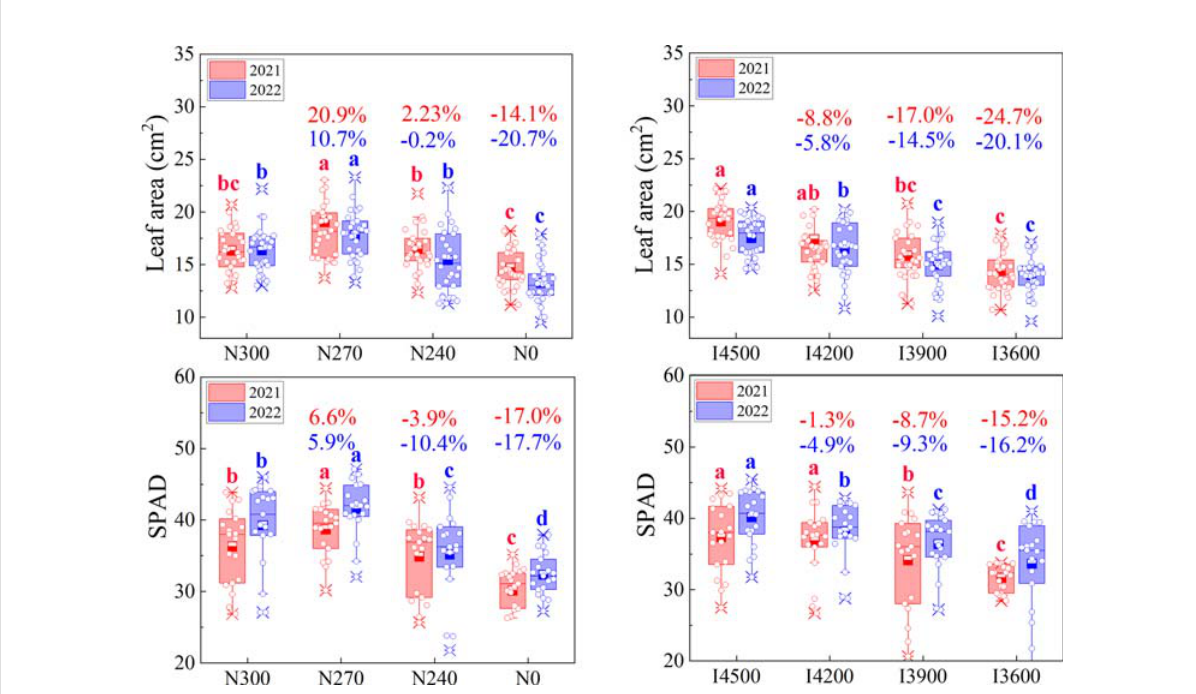
FIGURE 7 Effects of irrigation and nitrogen levels on fl ag leaf area and SPAD at anthesis stage. I4500, I4200, I3900, and I3600 indicate 4500, 4200, 3900, and 3600 m 3 ha − 1 irrigation levels, respectively. N300, N270, N240, and N0 indicate 300, 270, 240, and 0 kg ha − 1 nitrogen levels, respectively. The numbers in the columns indicate the percentage change in fl ag leaf area and SPAD under a given treatment compared with the traditional irrigation (I4500) and nitrogen (N300) levels. The lowercase letters refer to signi fi cant differences among the treatments at the 0.05